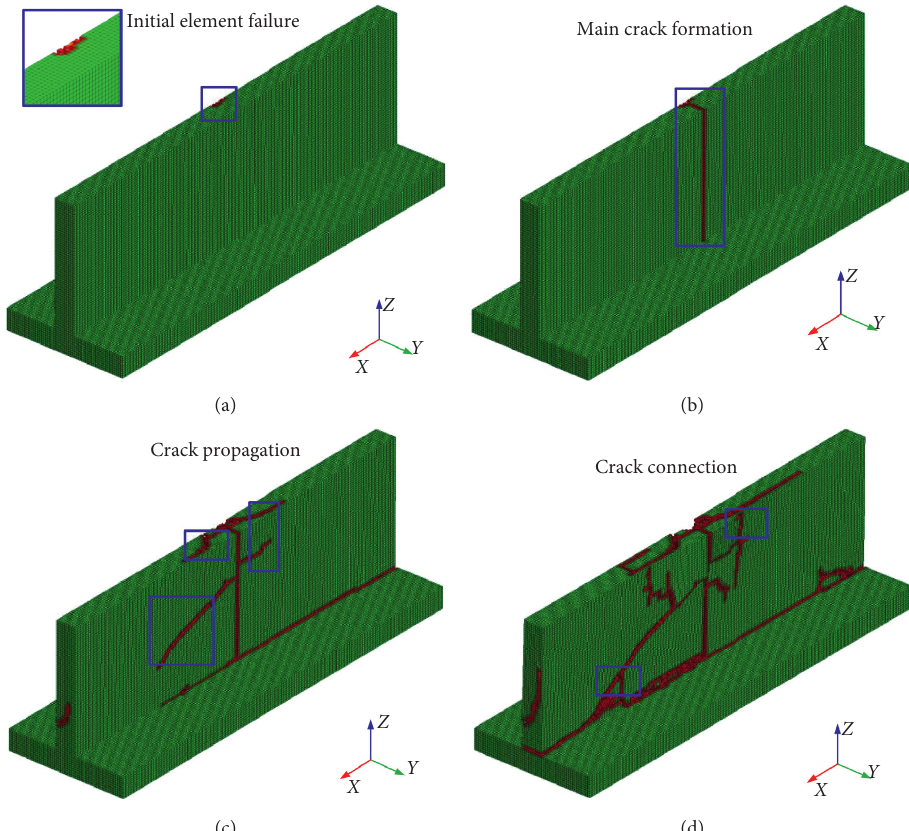
Figure 22: Cutting process of sandstone-1 with width of 400, height of 120mm, and thickness of 20mm: (a) initial element failure, (b) main crack formation, (c) crack propagation, and (d) crack